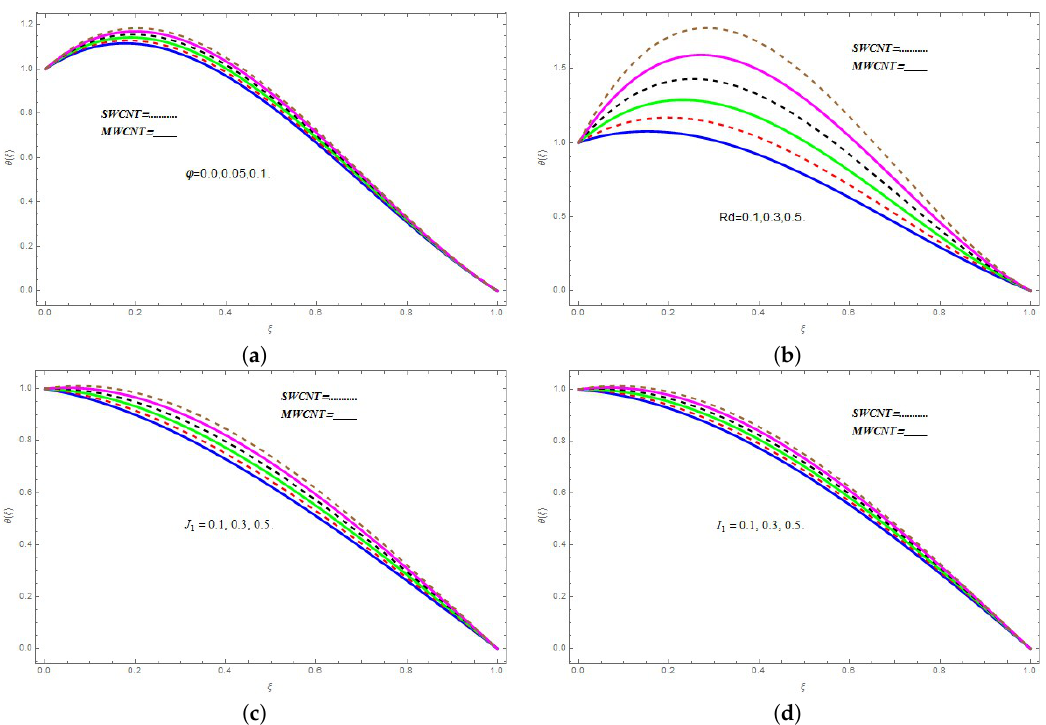
Figure 5. ( a ) Variations in θ ( ξ ) under different values of ϕ ; ( b ) Impact of Rd on θ ( ξ ) ; ( c )Impact of J 1 on